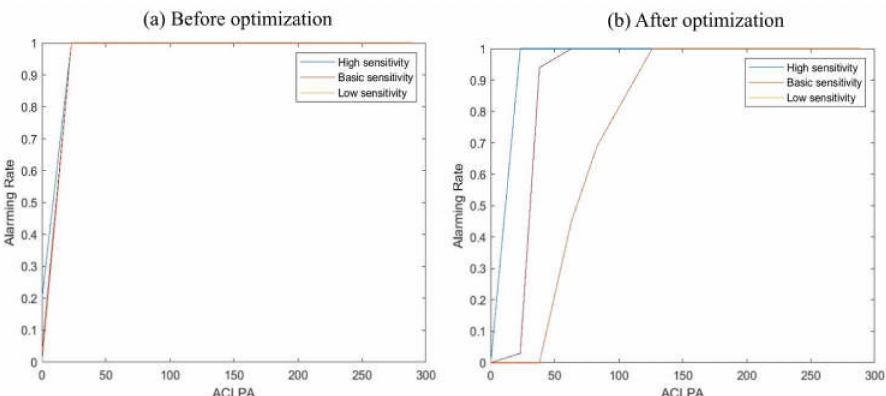
Figure 10. Sensitivity graph of the biological particle detector before and after applying the optimized algorithm that learned particle changes occurring in the South Korean